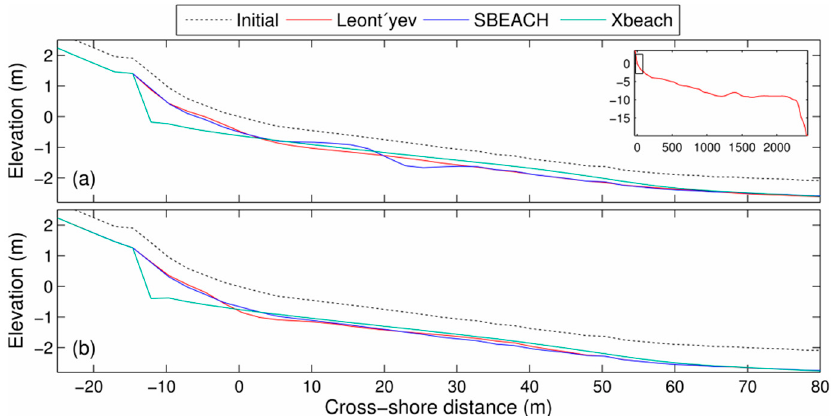
Figure 7. Cross-shore morphodynamic evolution of Negril beach at a representative beach profile (for location, see Figure 2). ( a ) cross-shore beach retreat under a storm surge of 0.2 m (the current 10-year event) coupled with a spring tide (+0.3 m above MSL); an offshore wave height (Hs) of 4 m and period of 9 s (at 20 m water depth) and a seabed sediment size (d50) of 0.73 mm are used. ( b ) cross-shore beach retreat under a storm surge of 0.2 m (the current 10-year event), coupled with a MSLR of 0.15 m (in 2060 assuming linear sea level rise of 3 mm/yr and a spring tide (+0.3 m above MSL); offshore wave height (Hs) of 4 m and period of 9 s (at 20 m water depth and seabed sediment size (d50) of 0.73 mm are used. Simulation times 3 h.